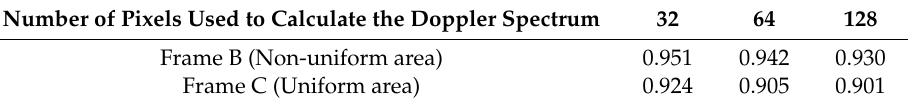
Figure 12. The comparison between the estimated spectrum, measured spectrum and theoretical spectrum. ( a ) Frame A in Figure 8; ( b ) Frame B and Frame C in Figure 9. Table 7. The effect of the number of pixels used to calculate the Doppler spectrum on the estimation results of b / F r